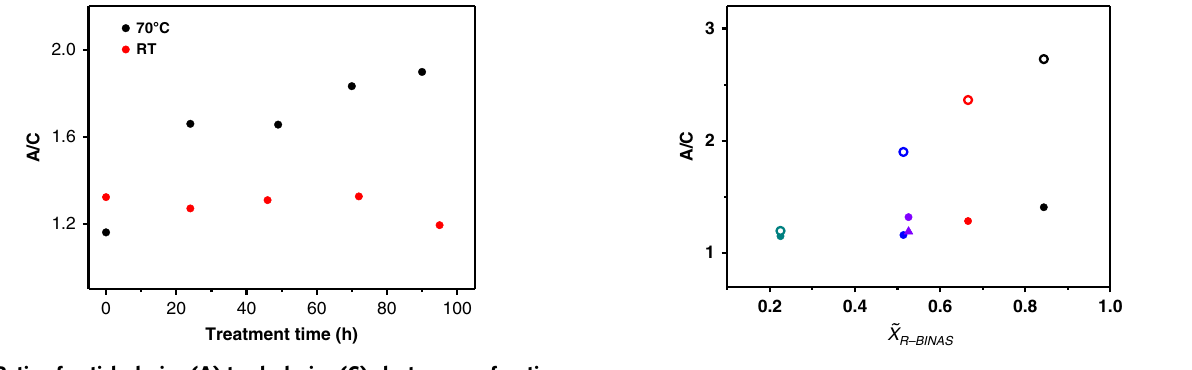
Fig. 3 Ratio of anticlockwise (A) to clockwise (C) clusters as a function Fig. 4 Dependence of A/C ratio on the average number of incorporated of time. Experiments were performed at room temperature (red points, BINAS ligands x R (cid:1) BINAS . Solid spots, before thermal treatment; hollow x ¼ 0 : 526) and at 70 °C (black points, x ¼ 0 : 514). spots, after thermal treatment at 70 °C for more than 70 h. Color code: R (cid:1) BINAS R (cid:1) BINAS Concentrations of cluster species were derived from peak areas in HPL green, x R (cid:1) BINAS ¼ 0 : 225; blue, x R (cid:1) BINAS ¼ 0 : 514; red, x R (cid:1) BINAS ¼ 0 : 666; chromatograms. Anticlockwise clusters (A): (A-38, 24, R-0) + (A-38, 22, black, x R (cid:1) BINAS ¼ 0 : 844; violet, x R (cid:1) BINAS ¼ 0 : 526 (triangle spot: sample R-1), clockwise clusters (C): (C-38, 24, R-0) + (C-38, 22, R-1). kept at room temperature for 95